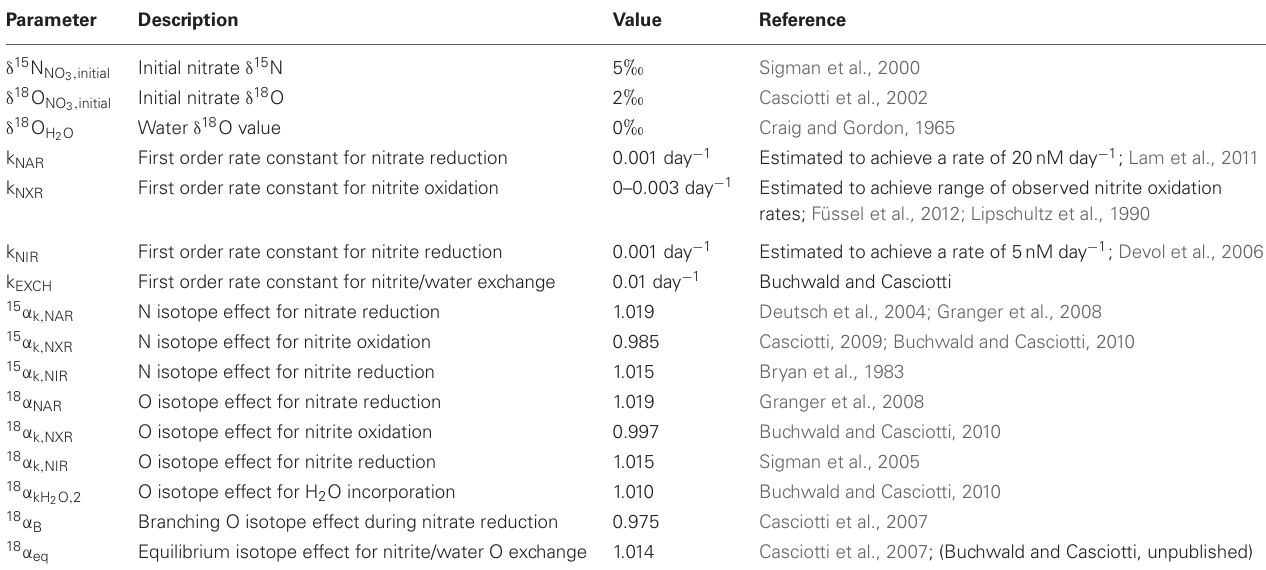
Table 1 | Parameters used in oxygen deficient zone box